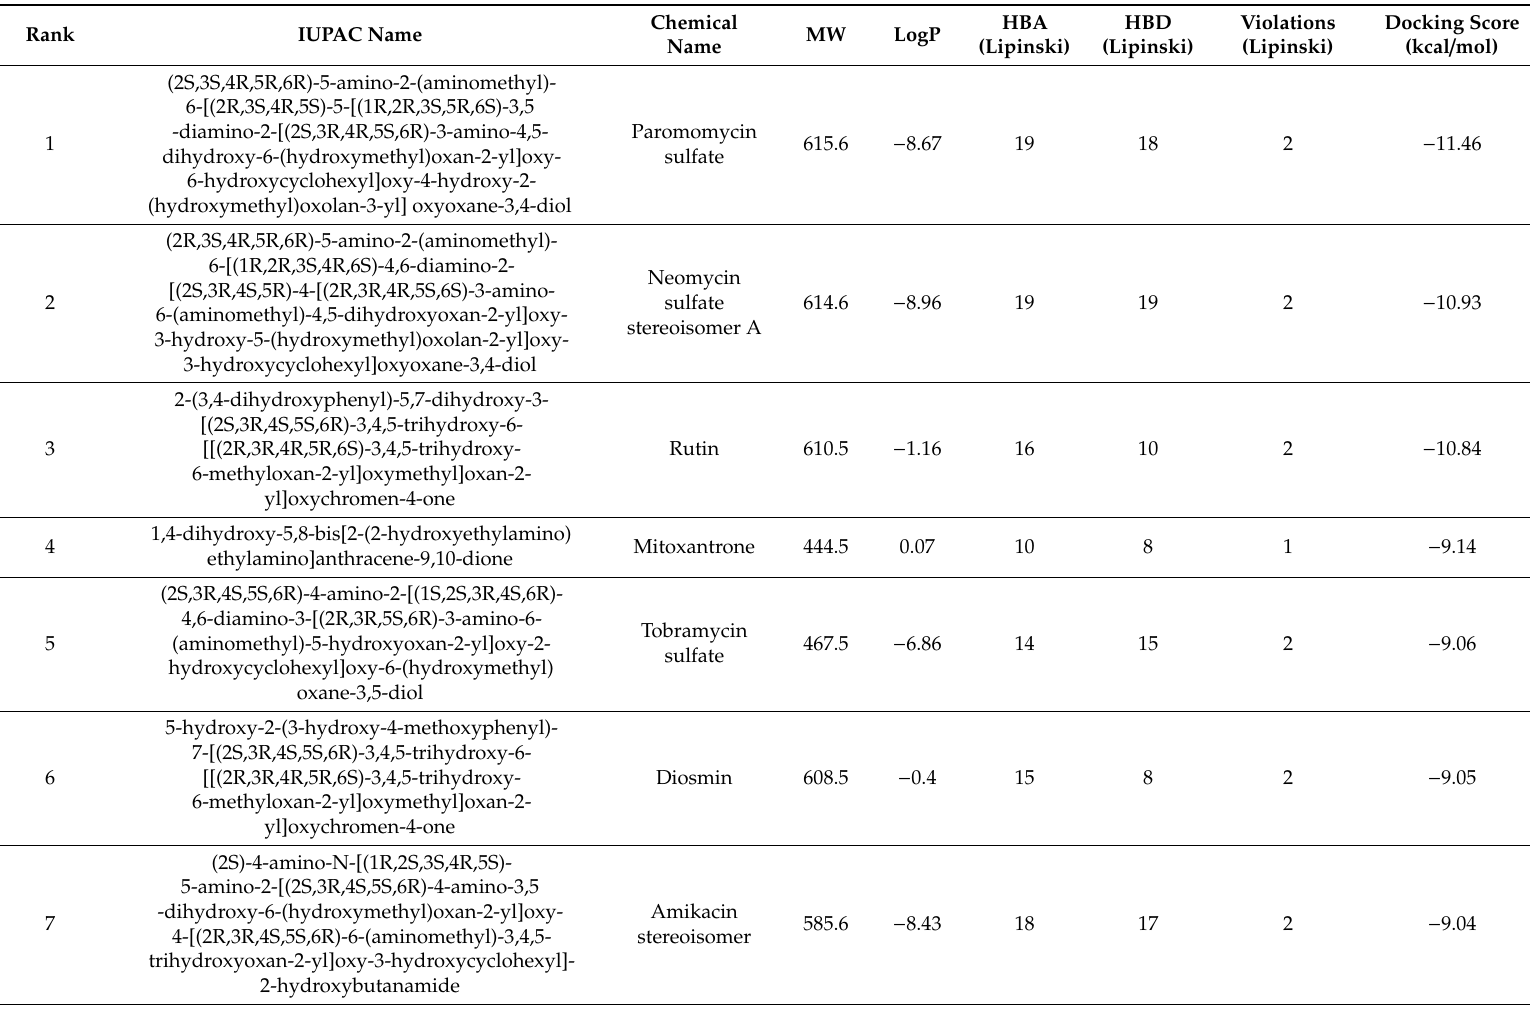
Table 2. Pharmacokinetic parameters important for good oral bioavailability and docking